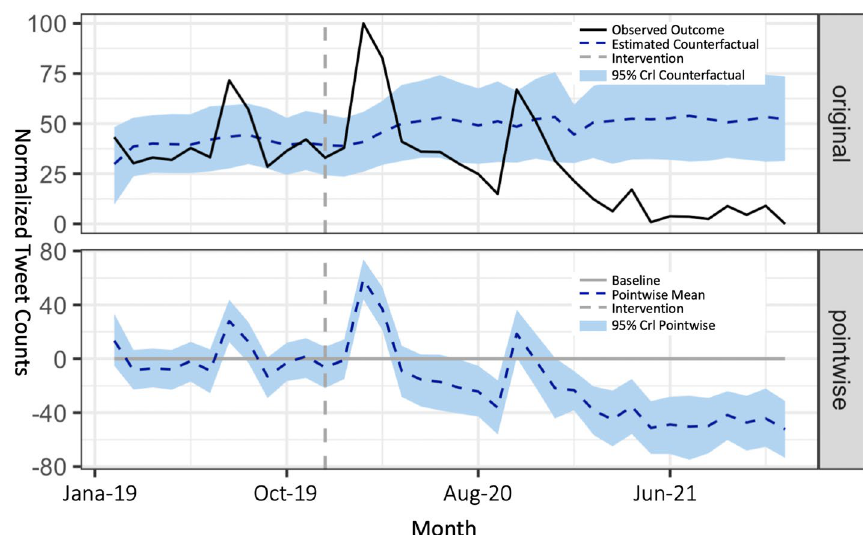
Fig. 4 Causal impact analysis of COVID-19 on grocery-related